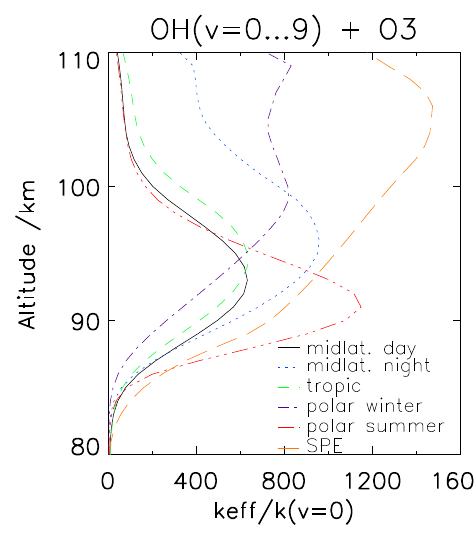
Fig. 3. Relative increase of the total OH( v = 0 ... 9 ) + O 3 rate co- efficients by consideration of vibrational excitation of OH in the reaction OH+O 3 as a function of altitude for various